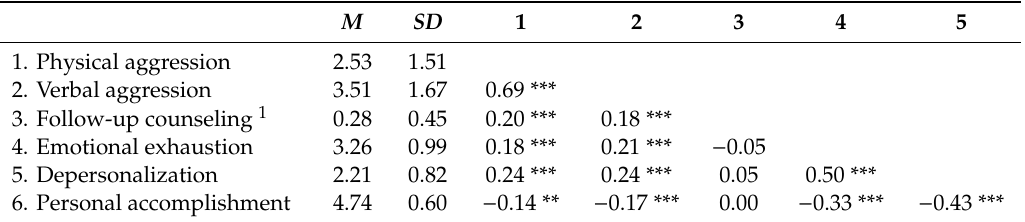
Table 1. Descriptive statistics and